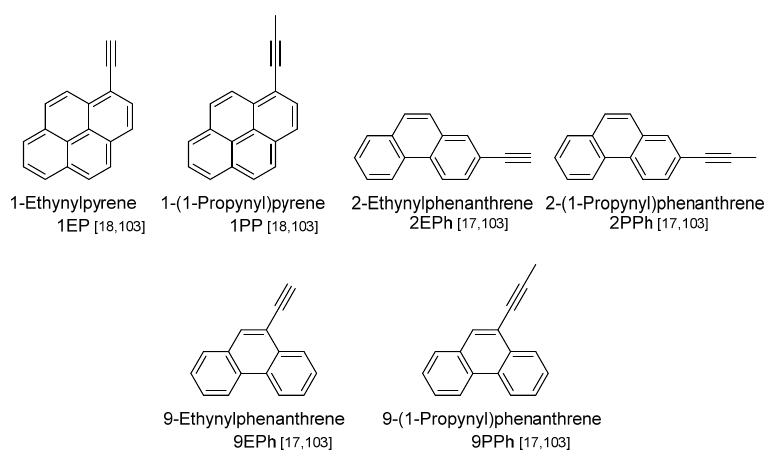
Figure 10. Selective MBIs with acetylenic